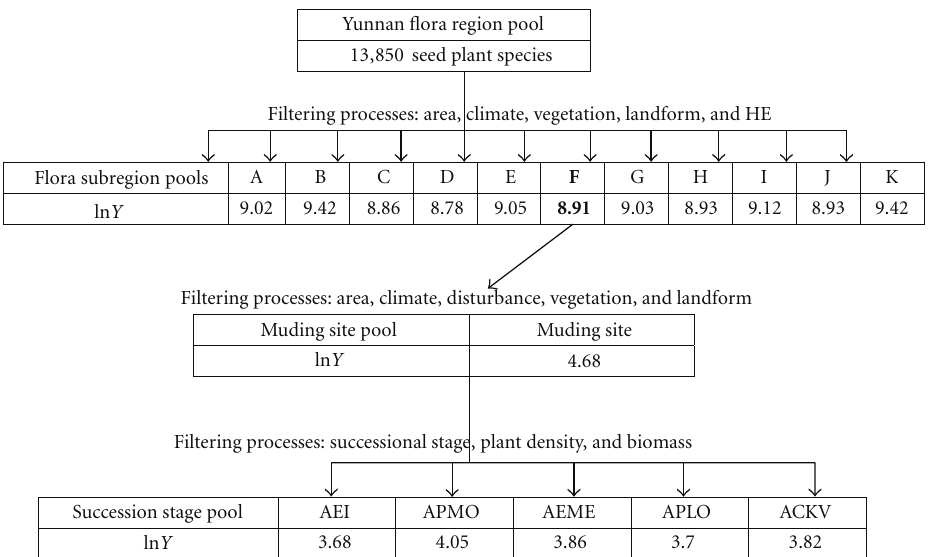
Figure 2: Filtering e ff ects (ln Y ) on plant species of neighboring large species pool at the Yunnan flora-subregion level, the Muding site pool level, and the successional stage pool